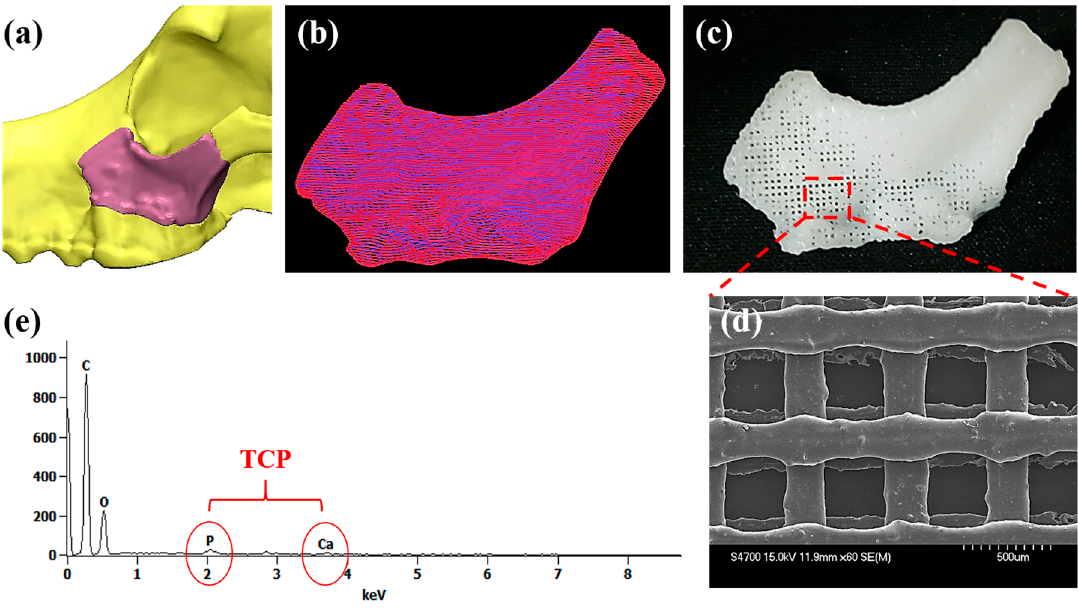
Figure 2. 3D printing procedure and characterization: ( a ) 3D reconstruction of the defect; ( b ) printing path generation; ( c ) the photograph of the printed scaffold; ( d ) SEM image; and ( e ) EDS results.